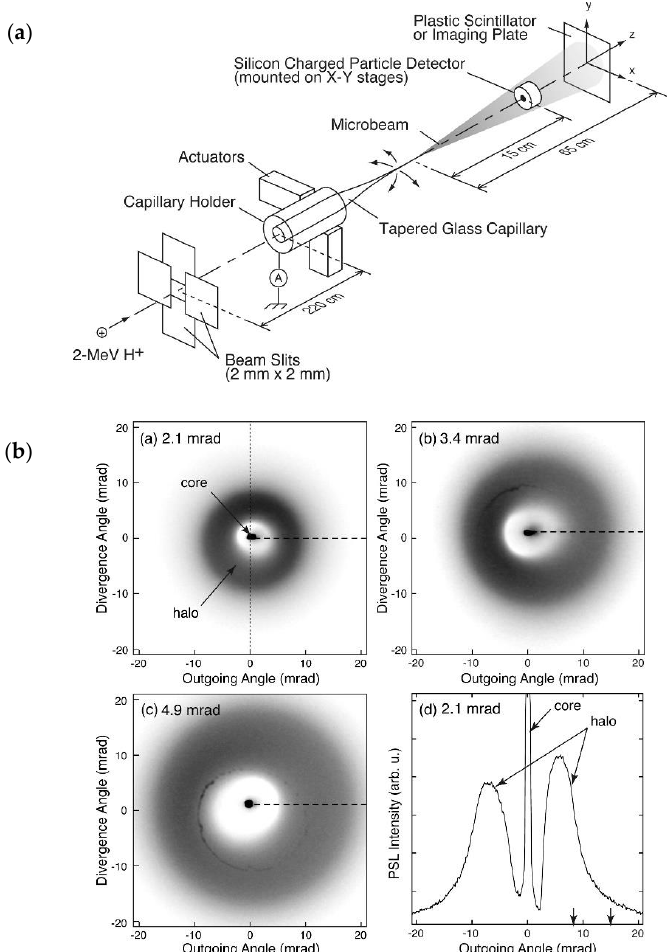
Figure 12. ( a ) Schematic representation of the setup (reprinted from [32], with the permission of AIP Publishing); ( b ) three irradiation patterns recorded on imaging plates according to the taper angles and a cross-sectional view showing “core” and “halo” (reprinted from [32], with the permission of AIP Publishing).